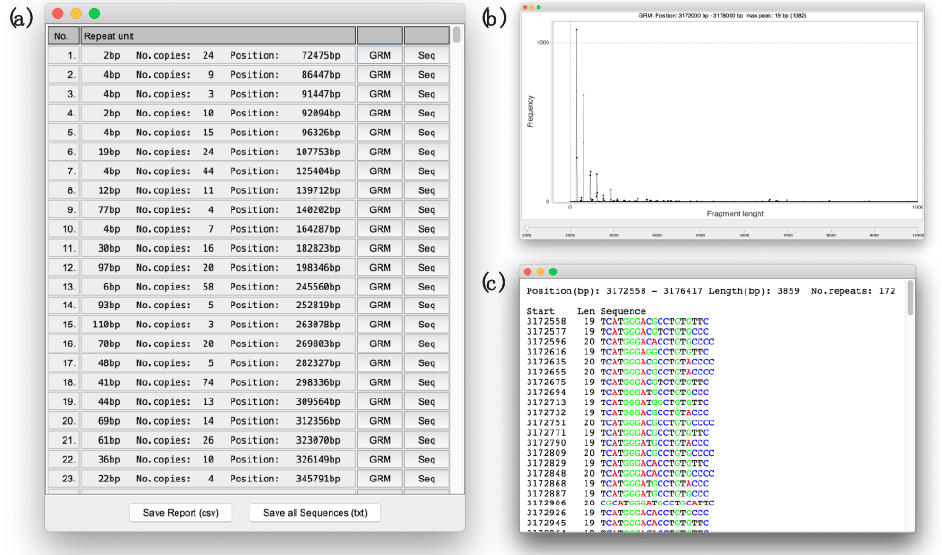
Figure 2. ( a ) The report listing of all TRs in the observed sequence. ( b ) The GRM diagram of the subarray in which chosen TR (No. 251, Repeat unit 19 bp, Supplementary Table S1) was found. ( c ) The report with the repetitive sequence (No. 22, repeat unit 19 bp, Supplementary Table S1) displayed as a series of basic repetitive units (19 bp).